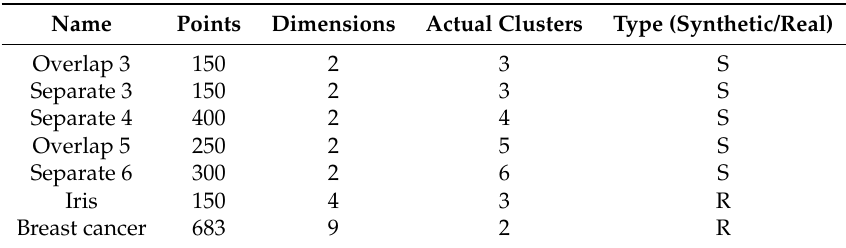
Table 1. Description of the